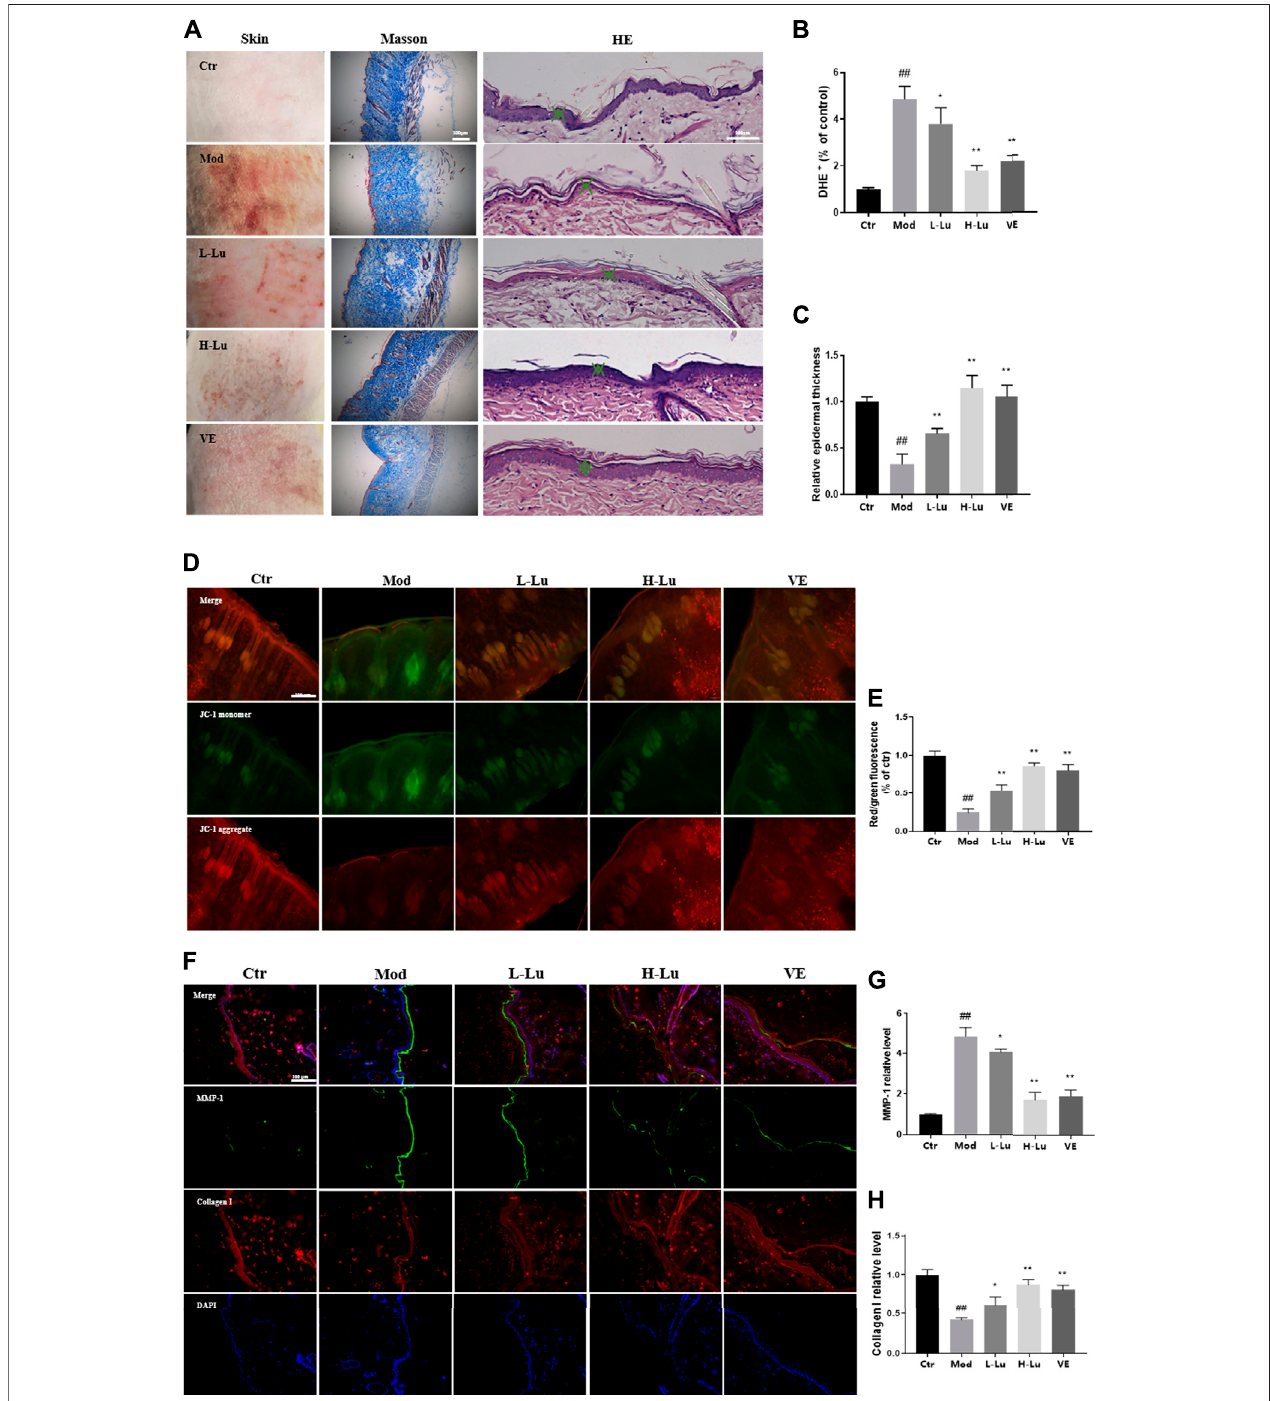
FIGURE1| Luteolin improvesthe condition ofthe skin onthe back ofrats damaged byUVB irradiation. (A) Changesin skin appearance, Masson and HE sections of rats in each experimental group. (B) The content of ROS in the skin of rats in each experimental group, red fl uorescence indicated ROS levels. (C) The relative epidermalthickness ofskin in each group. (D) JC-1 stainingresults ofskin ineach group, green representsmonomersand red representsaggregate. (E) The red/green fl uorescence ratio of skin in each group, the lower the ratio the lower the membrane mitochondrial potential. (F) Representative image of immuno fl uorescence staining for MMP-1 and Collagen I. (G) The relative fl uorescent intensity of MMP-1 of skin in each group. (H) The relative fl uorescent intensity ofCollagen I ofskin in each group. # indicates signi fi cant difference between the model group and the blank group (# p < 0.05; ## p < 0.01); * indicates signi fi cant difference between the administered group and the model group (* p < 0.05; ** p < 0.01).